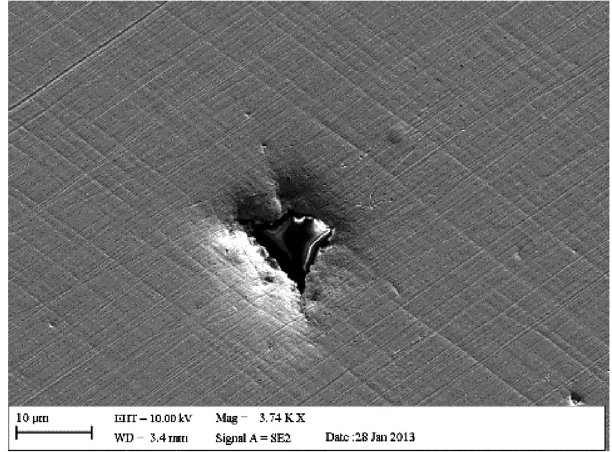
FIG. 21. SEM image of a diamond occlusion in the copper photocathode